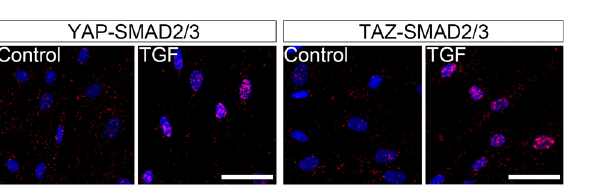
Figure 7. TGF-β1 stimulated localization of YAP/TAZ in close proximity to SMAD2/3 in HVOX fibroblasts. HVOX were treated with 10 ng/mL TGF-β1 for 24 h. Representative data of the proximity ligation assay using antibodies for YAP, TAZ and SMAD2/3 are shown (red = fluorescence raised by the assay, blue = cell nuclei stained with DAPI; bar = 50